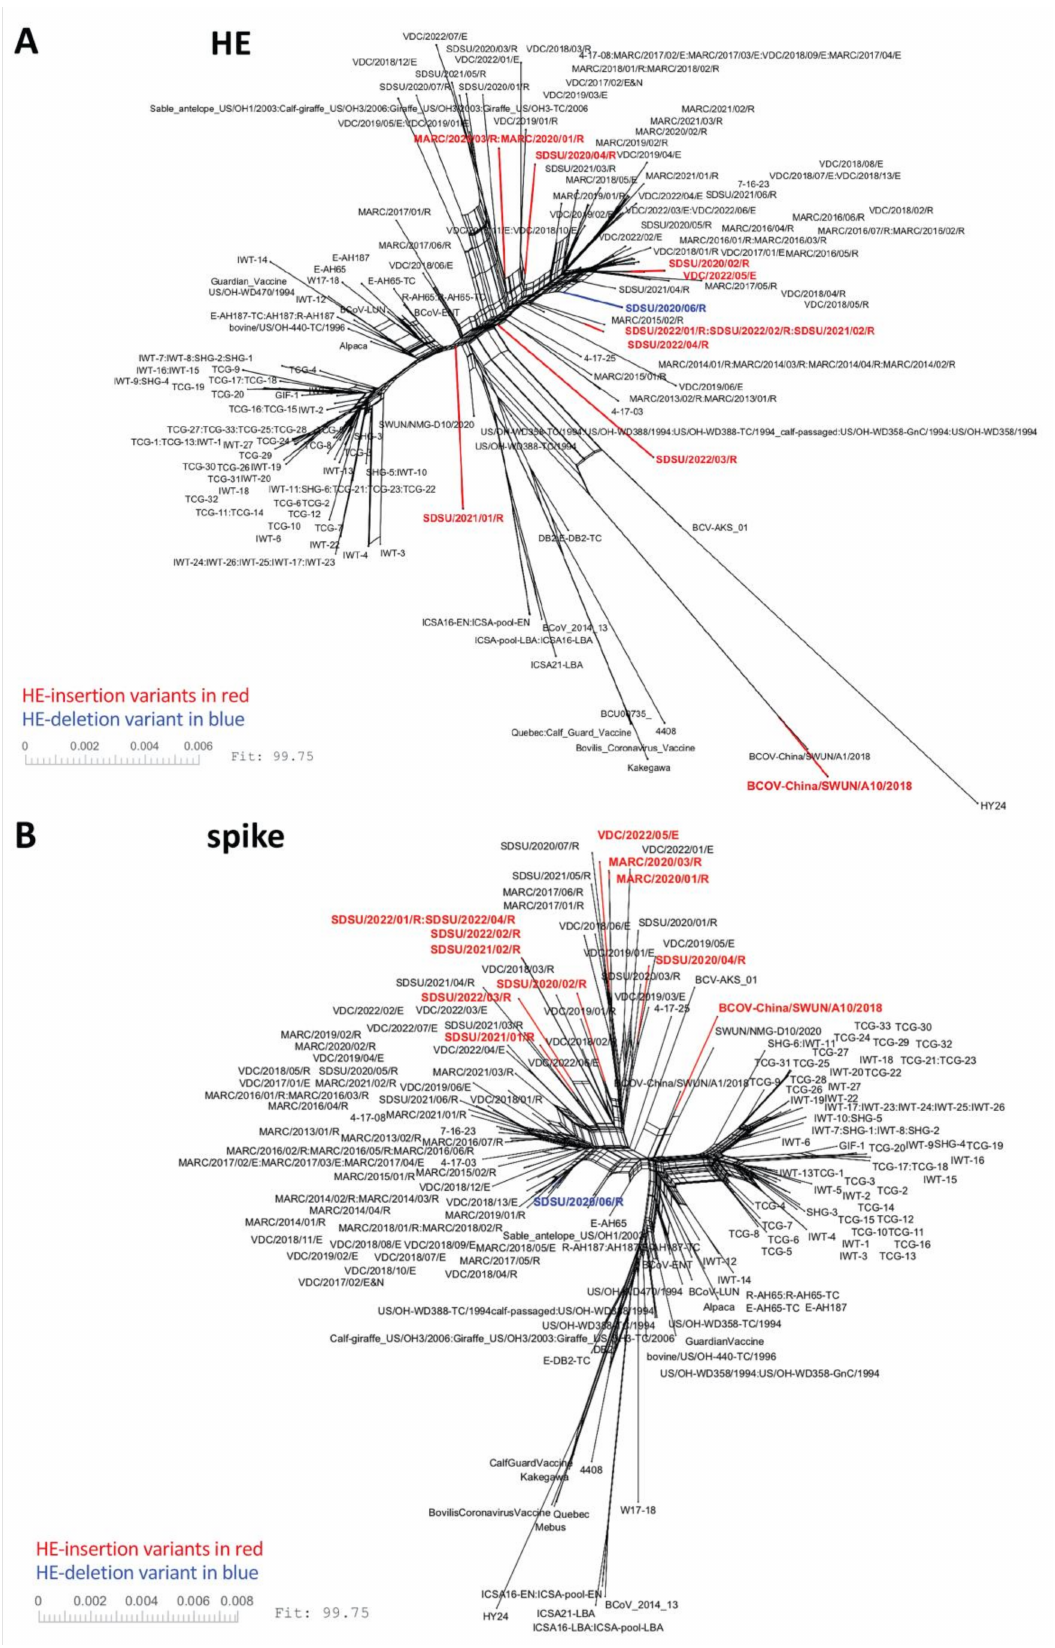
Figure 3. SplitsTree NeighborNet phylogenetic networks of 192 BCoV HE and spike genes. One hundred and ninety-two HE genes ( A ) or spike genes ( B ) were deduplicated, aligned using MAFFT, and analyzed with SplitsTree6. A list of the genomes used in this analysis can be found in Table